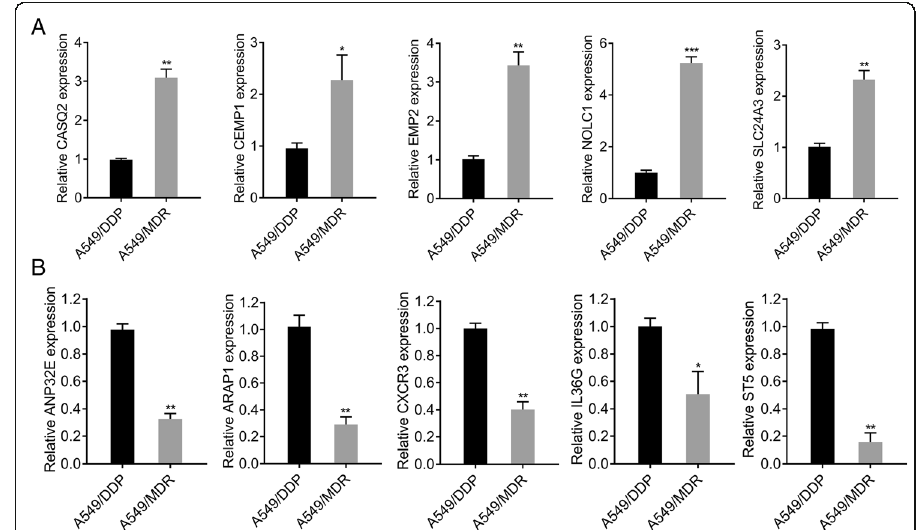
Fig. 3 Quantitative real-time PCR was used to confirm the microarray results in A549/DDP and A549/MDR lines. The expression levels of upregulated DEGs ( a ) and downregulated DEGs ( b ) were determined by qRT- PCR in A549/DDP and A549/MDR cell lines. GAPDH was used as an internal control. * p < 0.05, ** p < 0.01, *** p < 0.001 versus